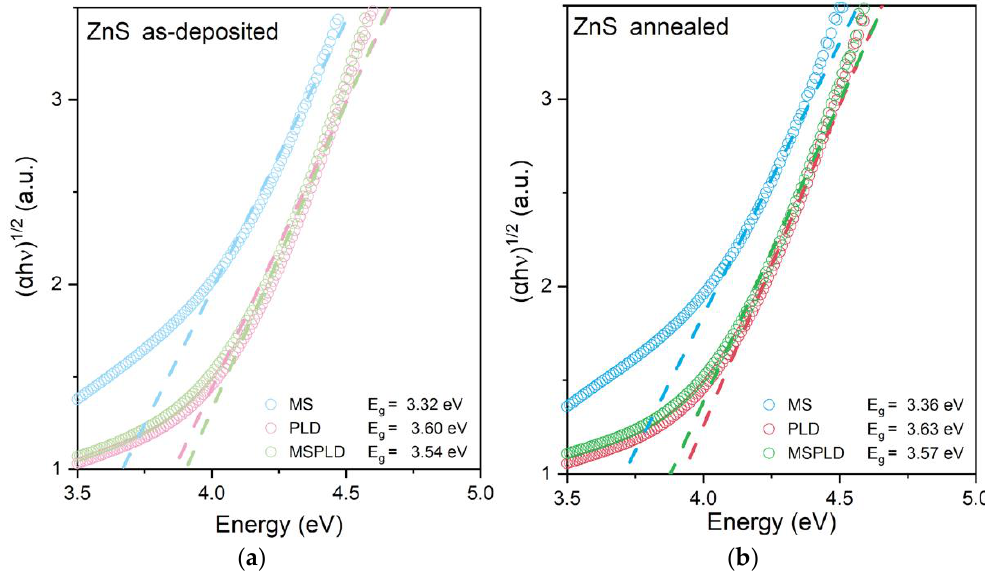
Figure 3. Tauc plots of ZnS films deposited on glass, by all three methods, in the ( a ) as deposited and ( b ) annealed states.